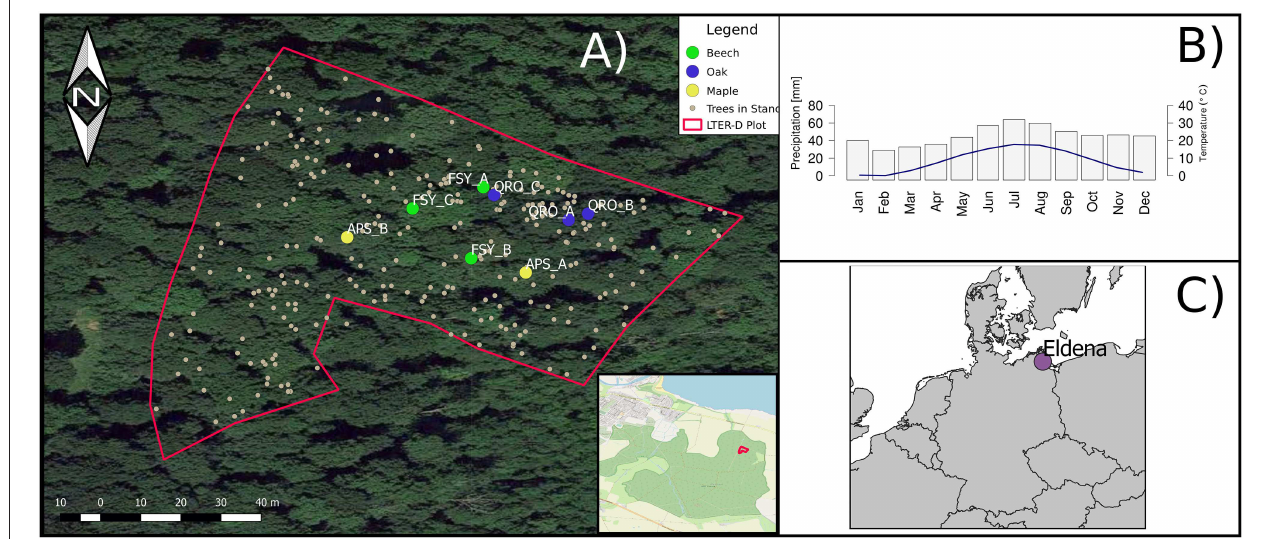
FIGURE 1 | General overview of long term monitoring plot and location of trees from the presented case study, where tree name abbreviations correspond to the species (Beech = FSY, Oak = QRO, Maple = APS) and letters to individual trees. The inset represents the location of the stand within the whole forest surface (A) ( OpenStreetMap Contributors, 2017). The pre-loaded data in DevX contains monitoring data (dendrometer series and histological images) from these individuals. Monthly average precipitation sums (gray bars) and temperature (blue line) of the site during the period 1901–2017 (B) , taken from CRU-TS 4.02 Dataset. Overview of location of case study site (C)